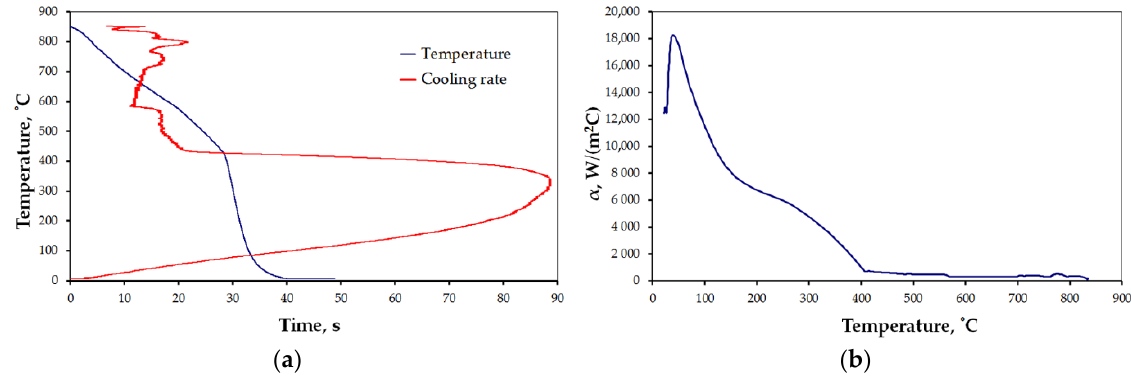
Figure 10. Results of measurement: ( a ) T = f( τ ) and v = f(T) , and ( b ) heat transfer coefficient for settings 5 (Table 1).